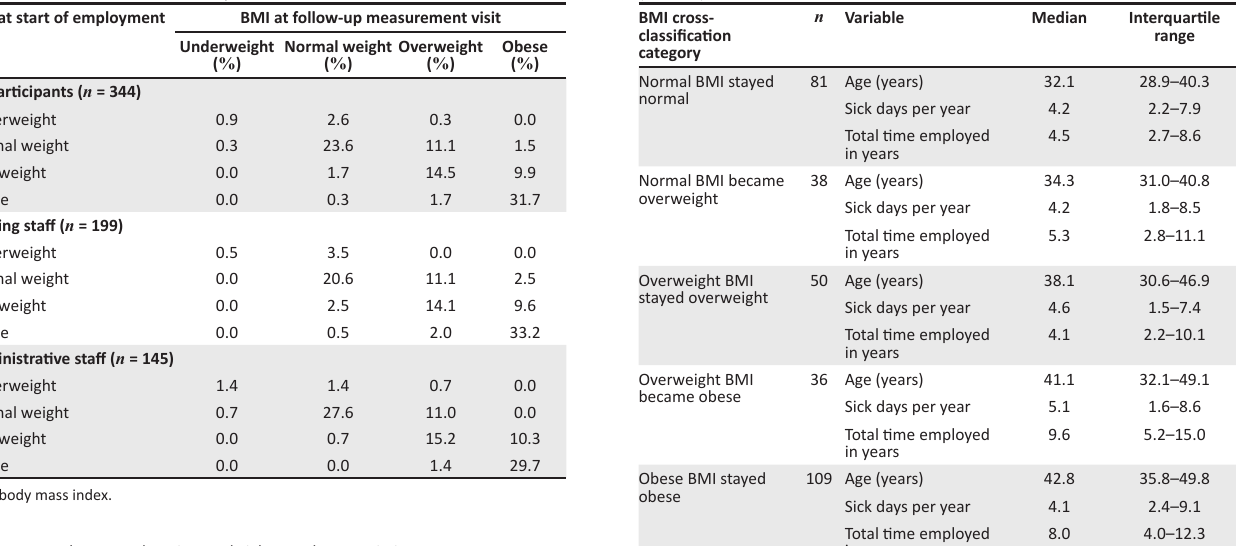
TABLE 4 : Employment duration and sickness characteristics. Variable Median Interquartile range